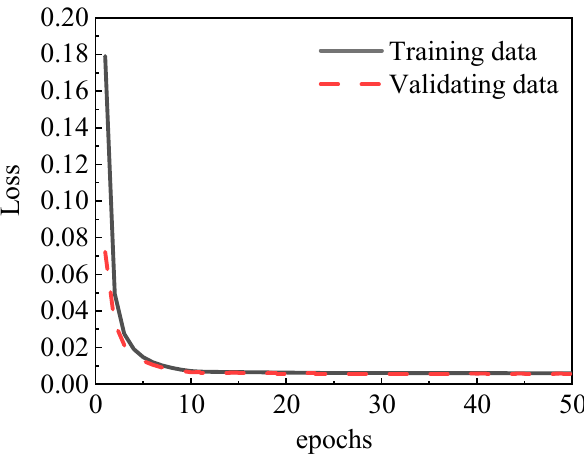
Figure 4. Loss curve of U-net model training.